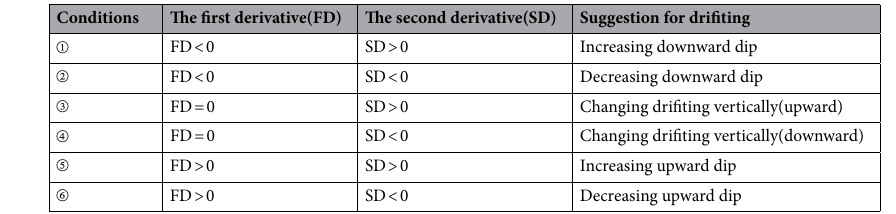
Table 3. The suggestion for drifiting based on derivative